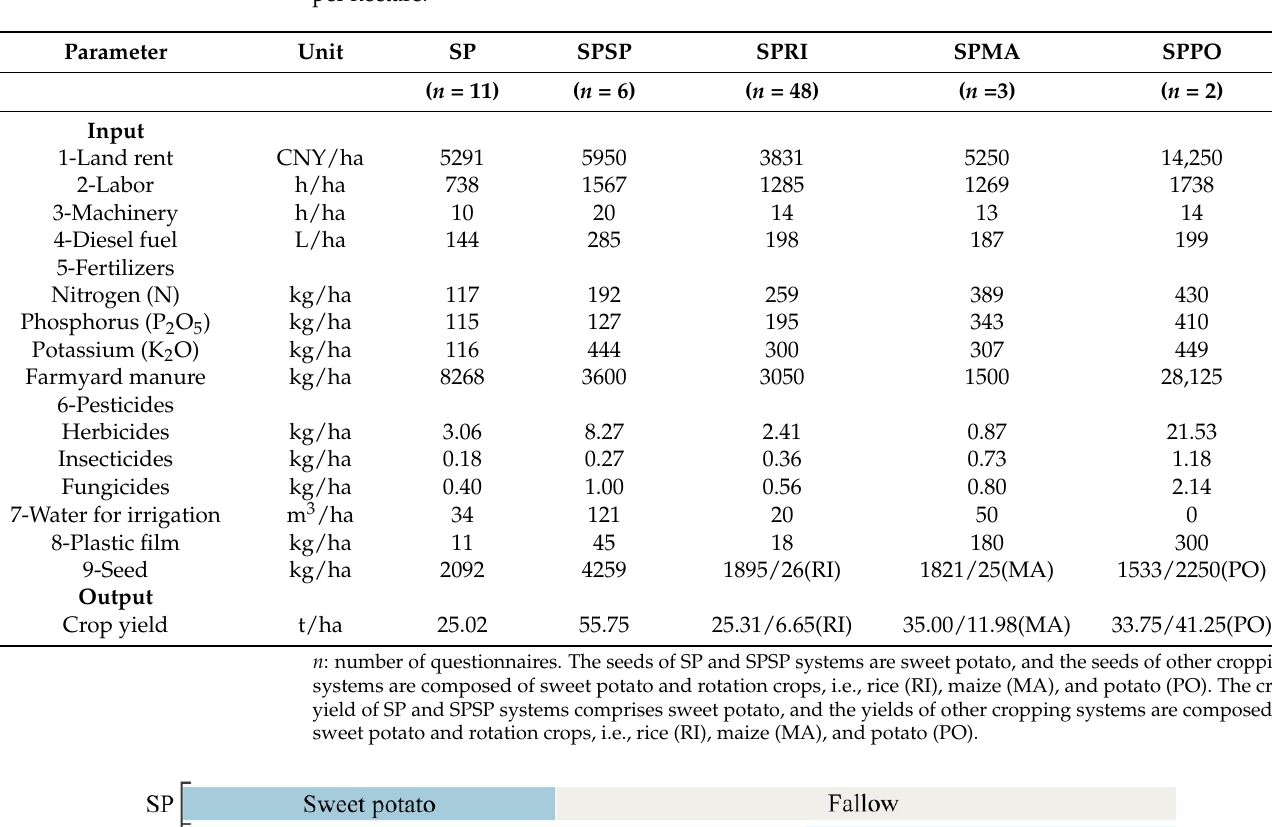
Table 2. Input and output data of five sweet-potato-based cropping systems in Guangdong province per hectare.